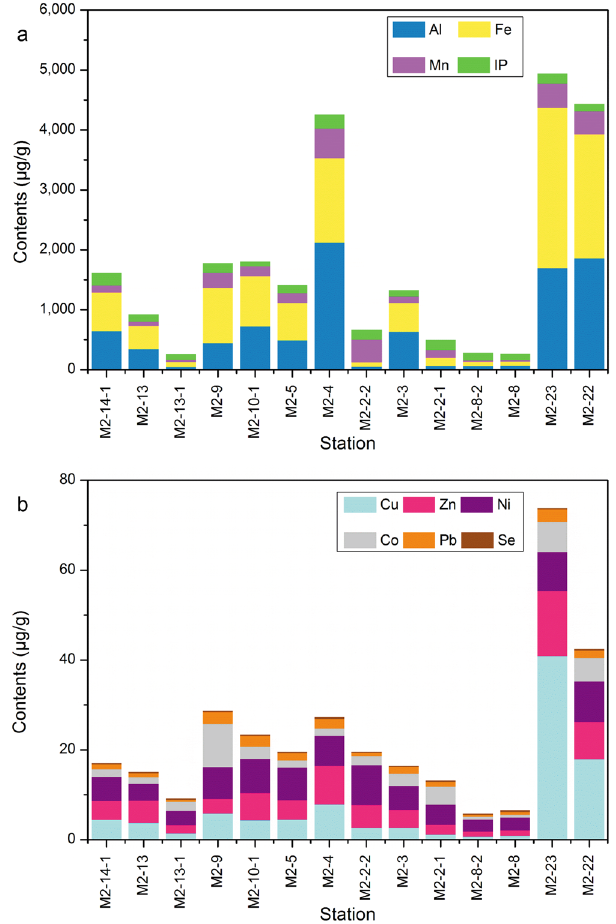
Figure 2. The concentrations of chemical elements in the sediments of the Kexue seamount. Panels a and b show the concentrations ( μ g/g) of major and trace elements, respectively, at the 14